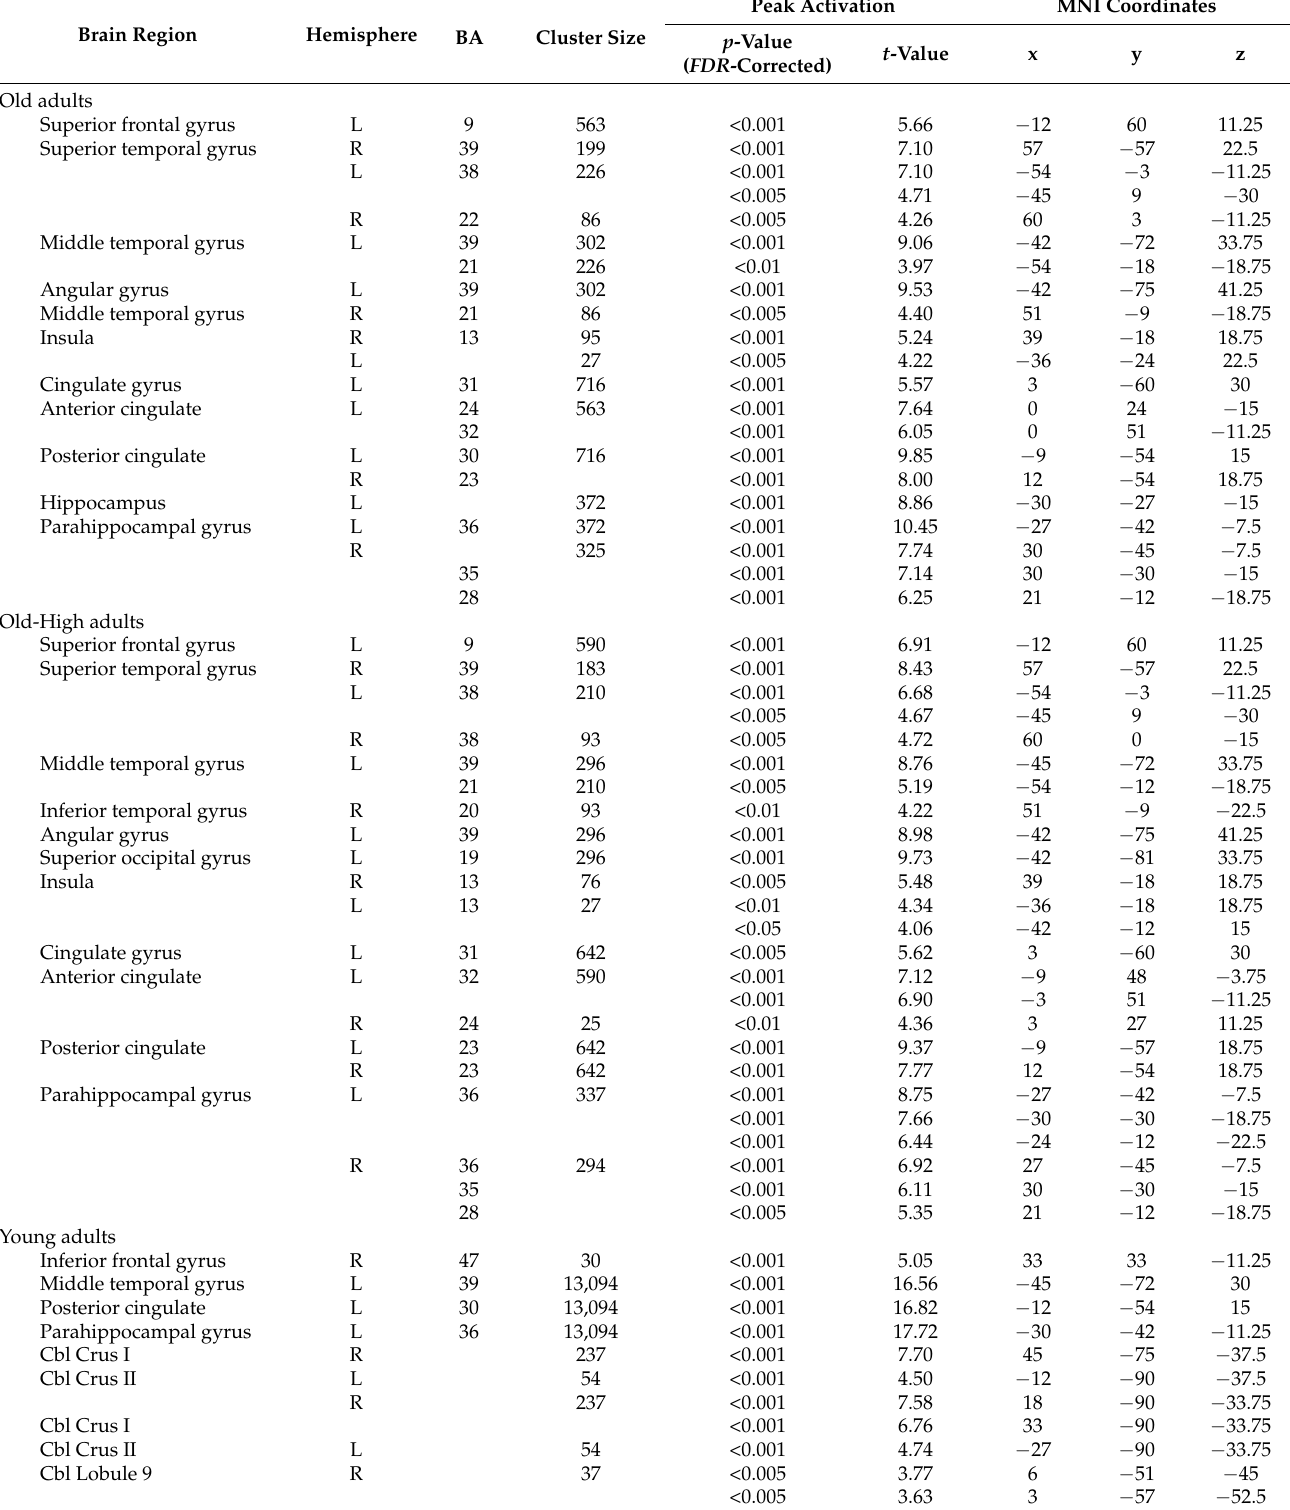
Table 2. Significant cluster-level activations for relational encoding of scenes (N > S contrast), at p < 0.05 ( FDR -corrected) with k ≥